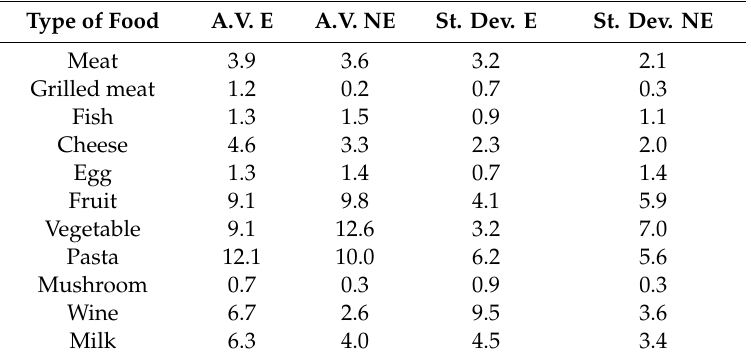
Table 4. Number of portions assumed by the E group and the NE group. Average value (A.V.) and standard deviations (St. Dev.).